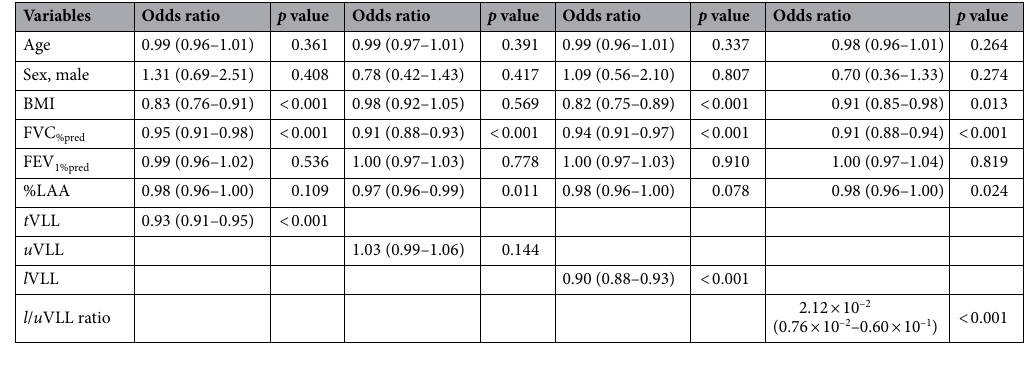
Table 4. Logistic regression analyses for idiopathic interstitial pneumonias. Data expressed as odds ratio (95% confidence interval). Odds ratios for continuous variables expressed as per 1 value increase. BMI body mass index, FEV 1%pred percentage predicted forced expiratory volume in 1s, FVC %pred percentage predicted forced vital capacity, tVLL total vertical lung length, uVLL upper vertical lung length, lVLL lower vertical lung length, %LAA percentage low-attenuation area.